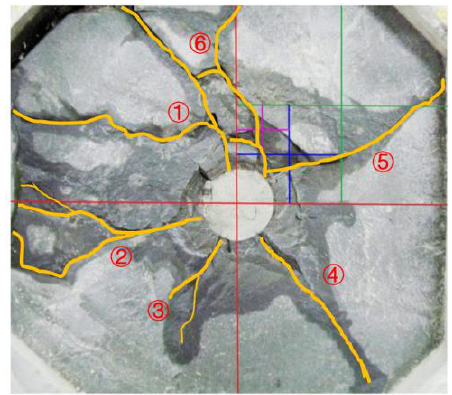
Figure 2. Core fracture network experiment result. A total of six cracks are generated after fracturing. ④ and ⑤ grow only single fractures perpendicular to the wellbore, but ①, ②, ③, and ⑥ split into two branches after propagating a few centimeters, modified from Guo et al.